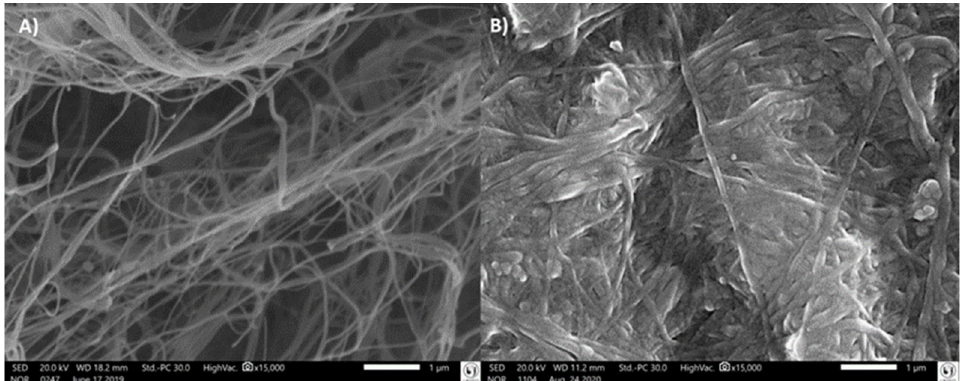
Figure 4. Scanning electron microscopy of the bacterial cellulose (BC) ( A ) and the bacterial cellulose loaded with nisin (N–BC) ( B ), at 15,000× magnification.